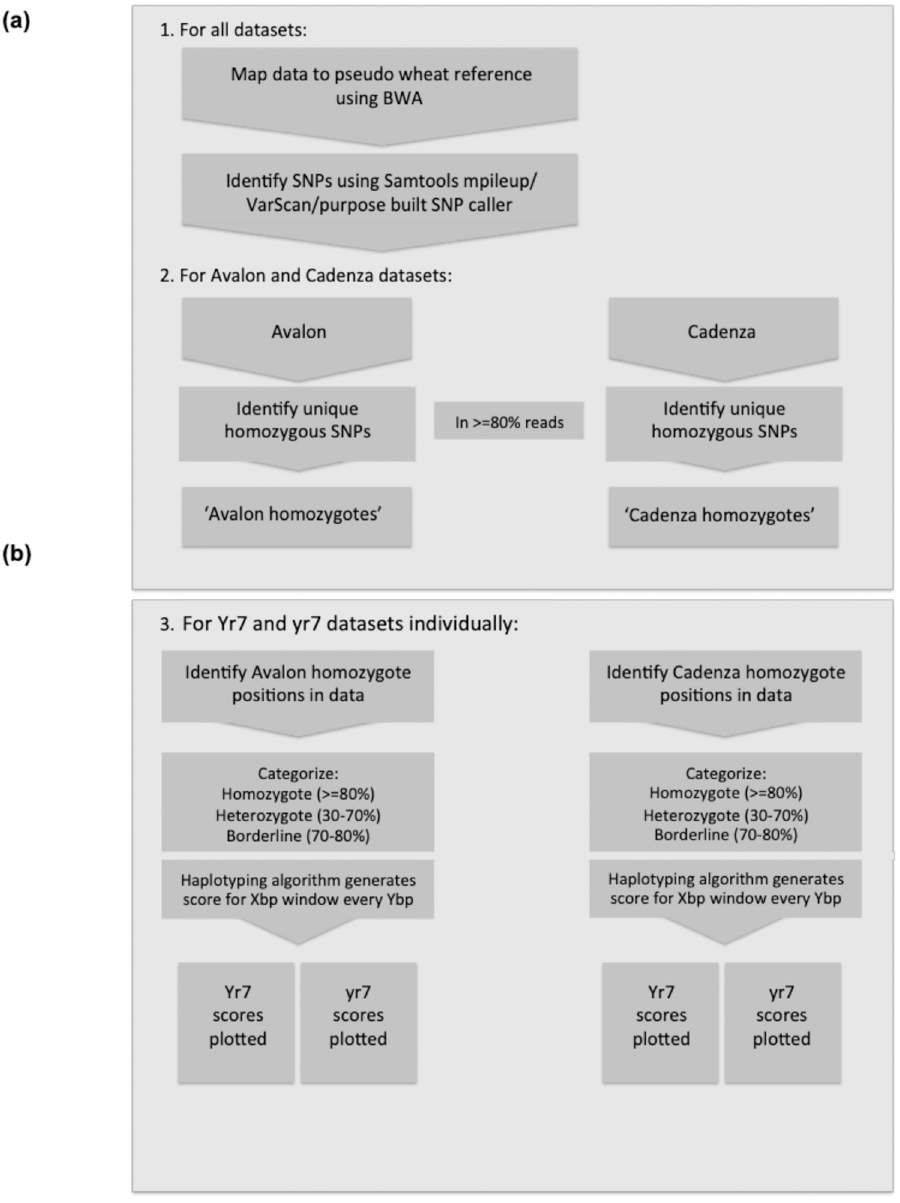
Fig 1. Processing four sets of enriched sequencing data to identify a mapping interval containing the gene controlling the phenotype of interest. (a) Standard mapping and SNP calling pipeline to construct “reference genomes” (b) Pipeline implementing an algorithm to score regions of interest by prioritizing long homozygous parental haplotypes for the bulk segregant samples to identify the interval of interest. Shown here using Xbp windows at Ybp intervals (user defined) and standard homozygote, heterozygote and borderline SNP definitions for a diploid- values can all be adjusted throughout the analysis as necessary.